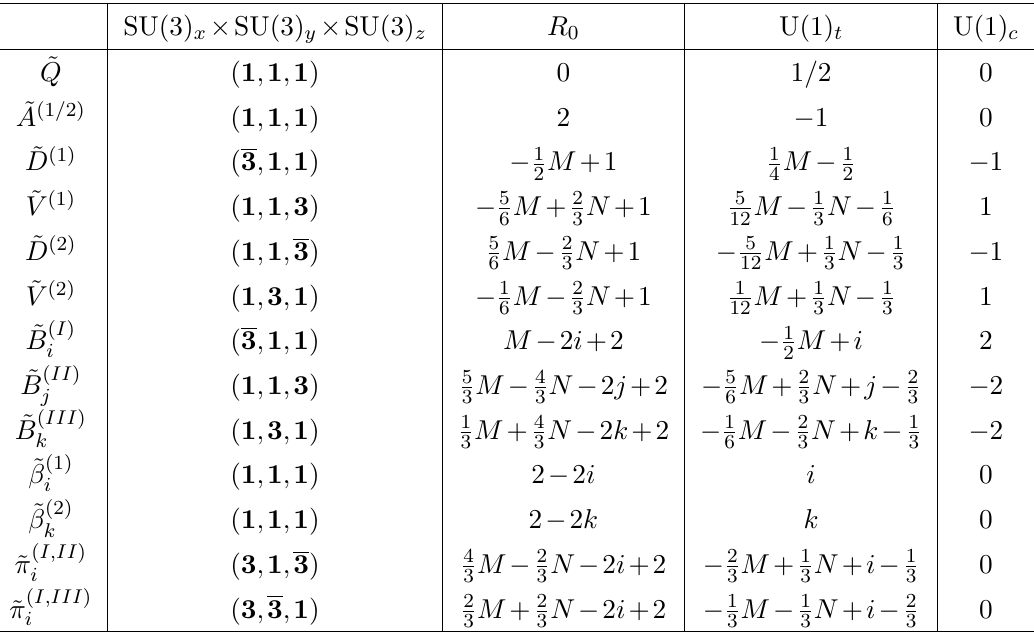
Table 7 . Charges and representations of the matter fields of Theory B under the global symmetry.